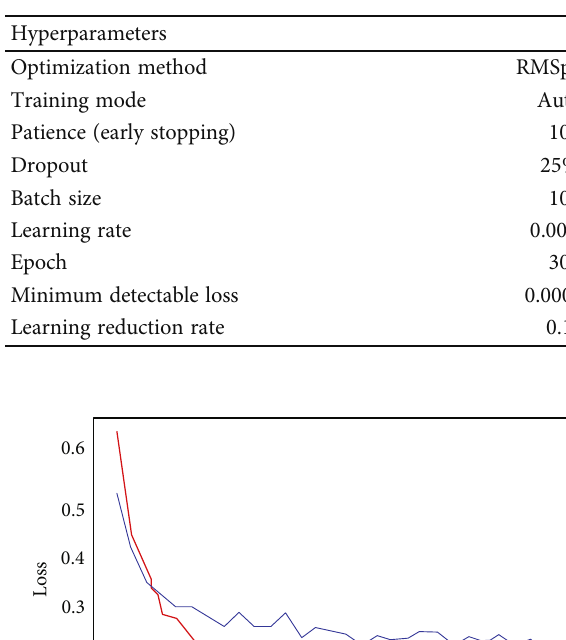
Algorithm 2: Steps to classify the X-ray images using machine learning Table 2: The best-trained model parameters for VGG16.